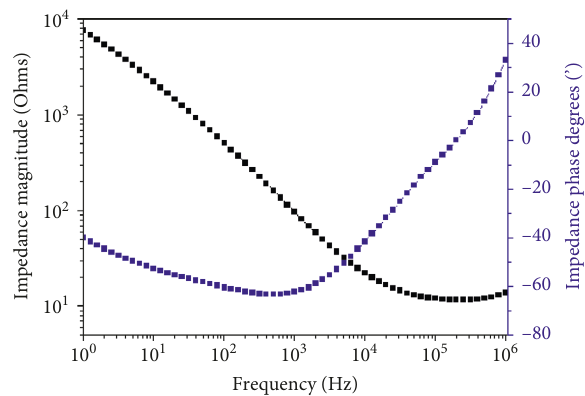
Figure 3: HAC-EDTA impedance spectrum, whose line decay exhibits storage capacity of up to approximately 50,000Hz.